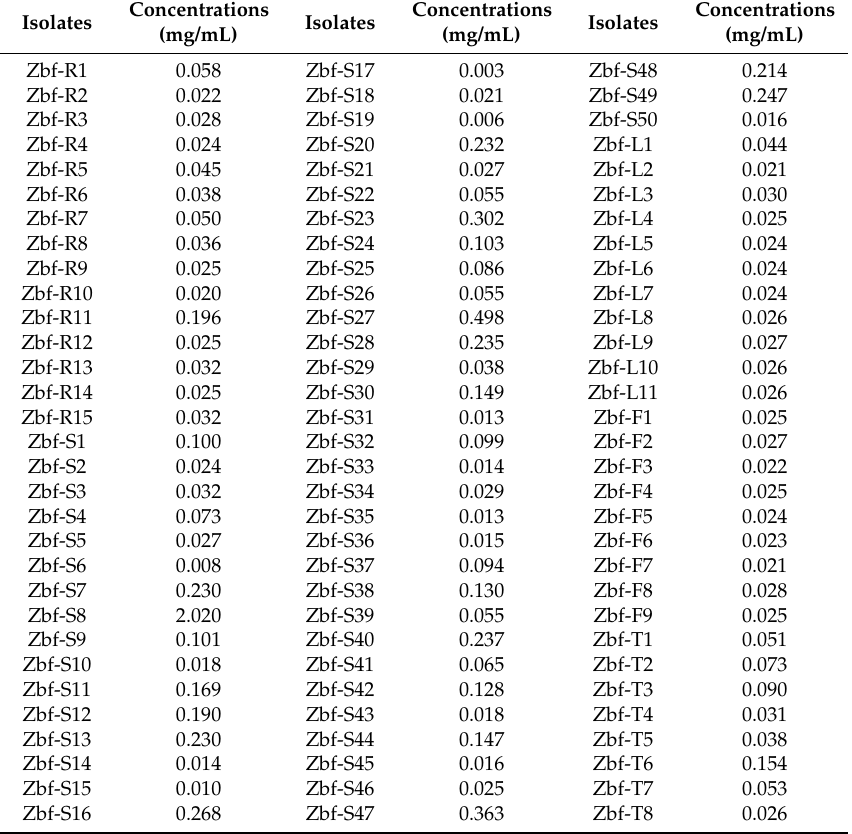
Table 5. Concentrations of crude extracts of 93 endophytic fungal isolates in antifungal assays against pathogenic fungi F. sambucinum and P. zanthoxyli